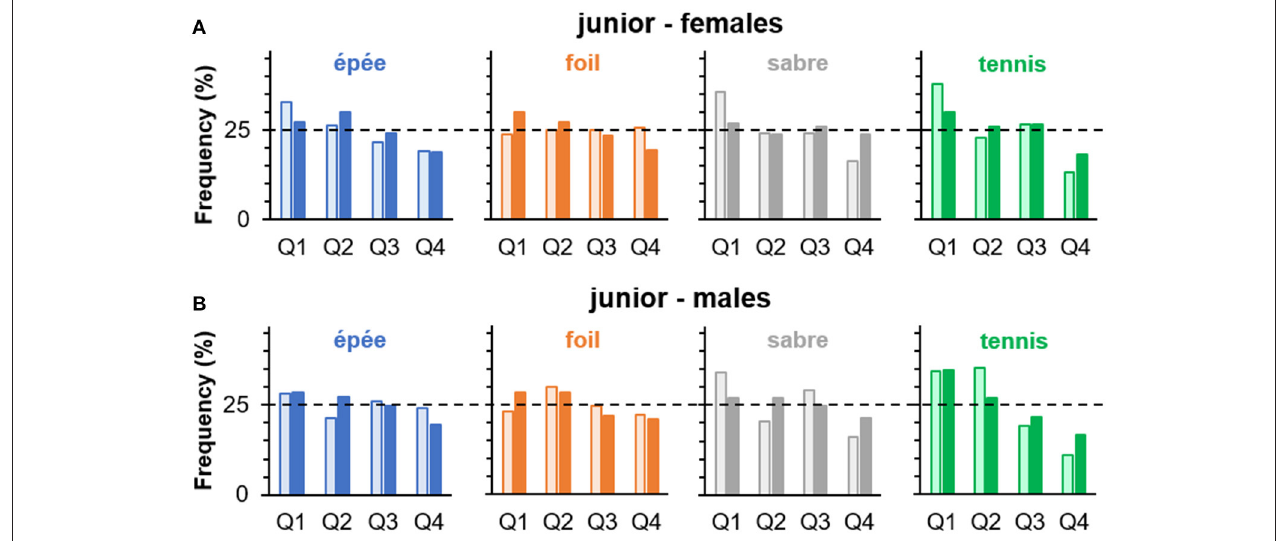
FIGURE 4 | Percentages of birth quartile (Q1–Q4) frequencies in left- ( (cid:3) ) and right-handers ( (cid:4) ) separately for sport or discipline in (A) female and (B) male junior athletes (study 2). Horizontal dashed lines indicate expected frequencies under the assumption of a uniform